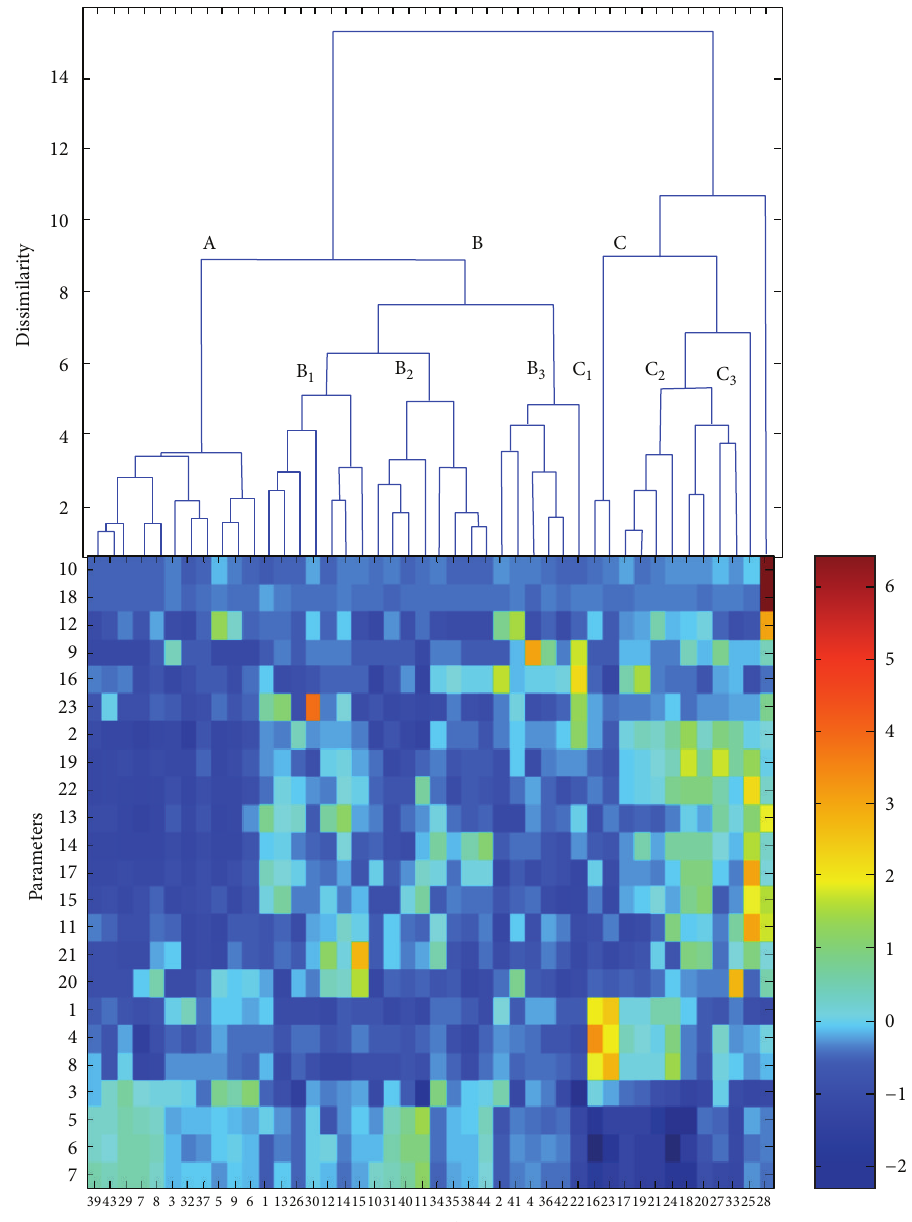
Figure 5: Dendrogram of 44 hard coal samples from various coal mines of the USCB (objects) in the space of the 23 measured parameters with the color map of the studied data sorted according to the Ward linkage